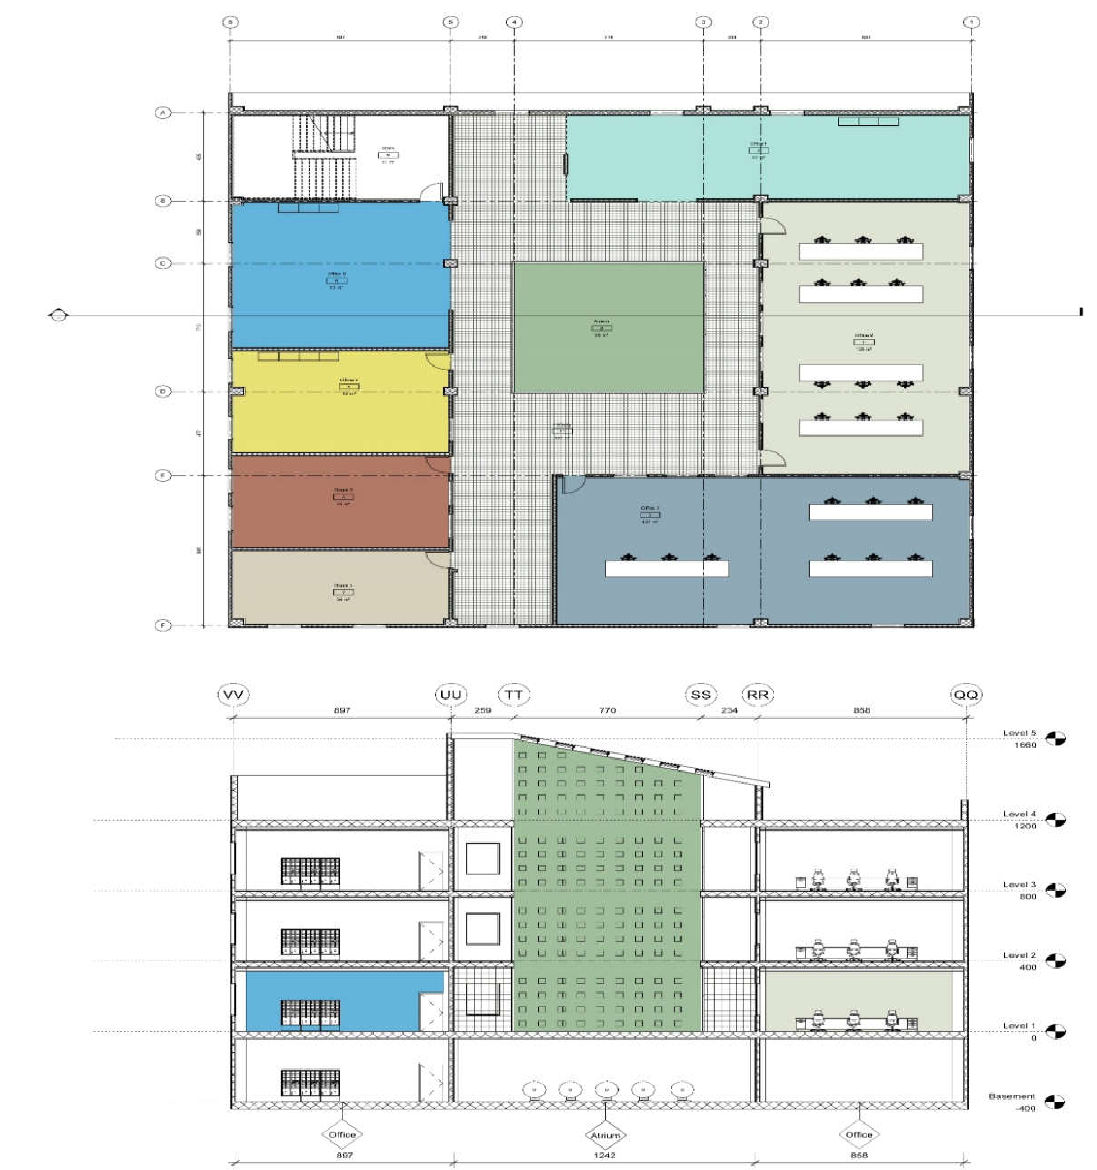
Fig. 1: Floor plan (above) and cross section (below) of the atrium